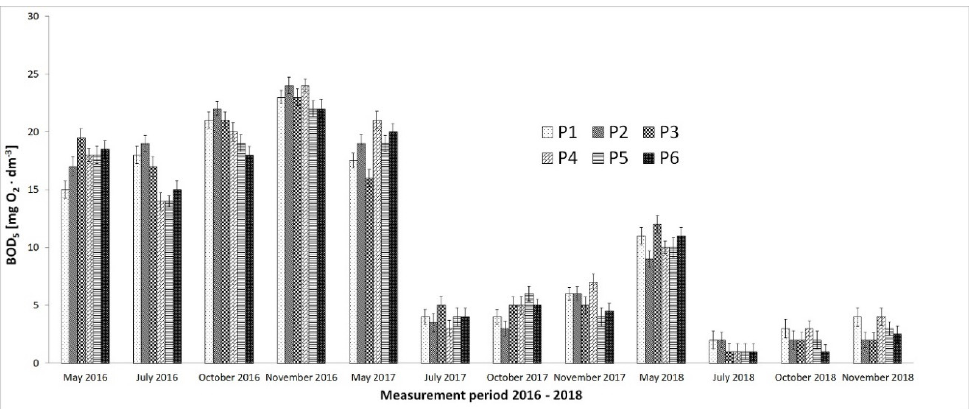
Figure 7. Changes in the BOD 5 (Biochemical Oxygen Demand) value at points P1–P6 in the reservoir. Measurement campaigns 2016–2018. Water 2020 , 12 , x FOR PEER REVIEW